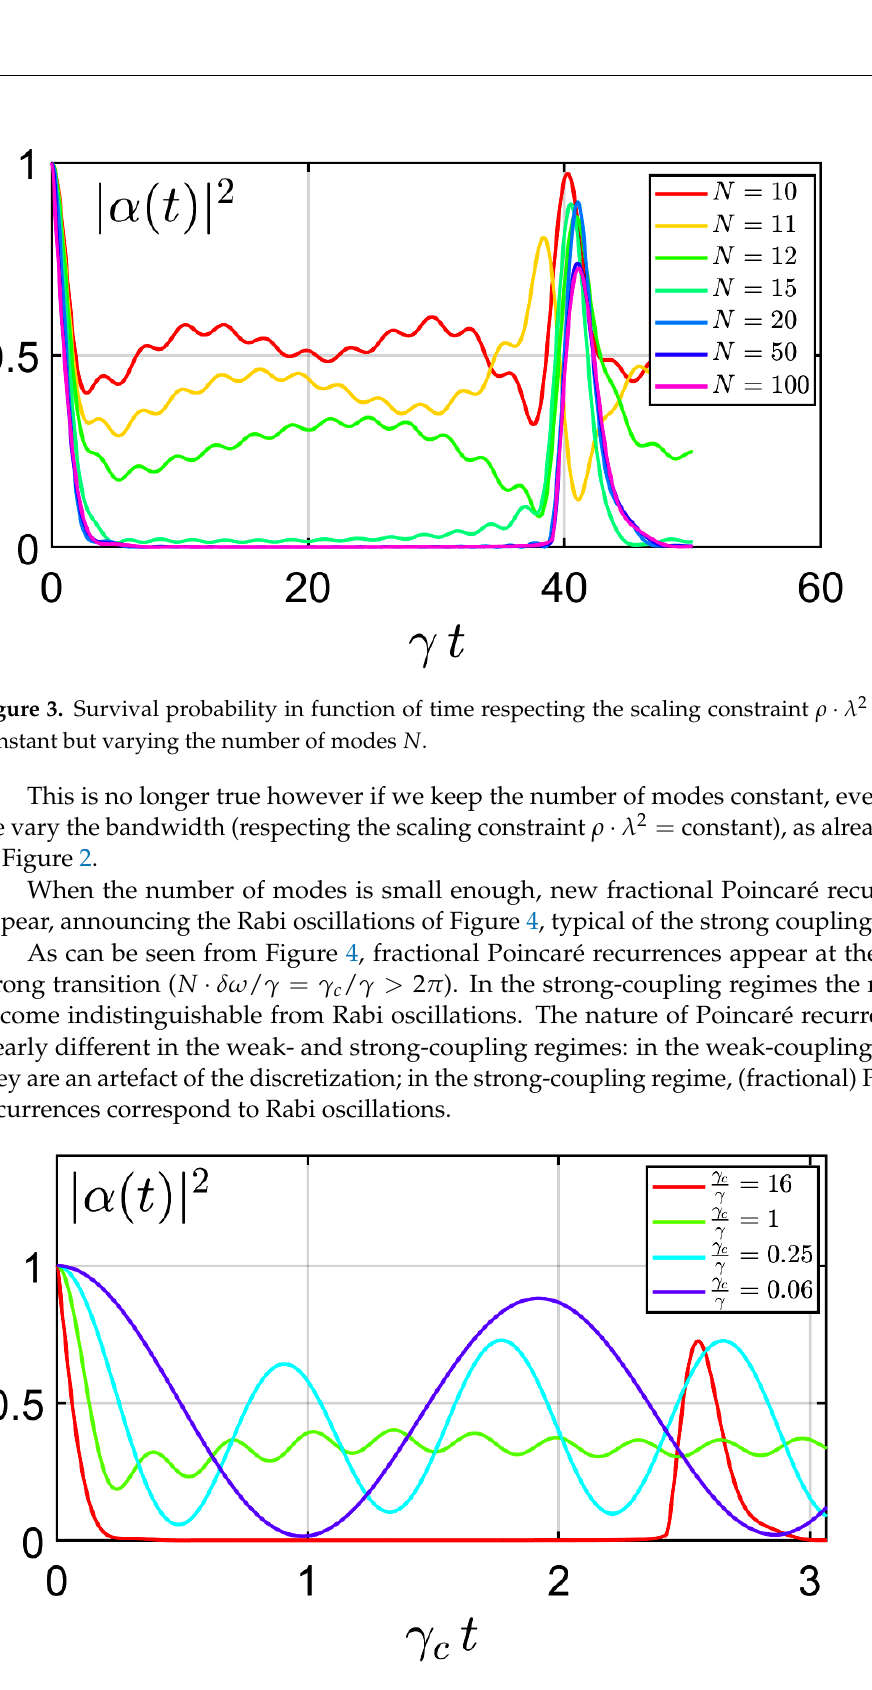
Figure 4. Survival probability in function of time for various values of γ c / γ . In the weak-coupling regime, the Poincaré recurrence is an artefact of discretization, whereas in the strong-coupling regime Poincaré recurrences become indistinguishable from Rabi oscillations, typical of a system consisting of two coupled